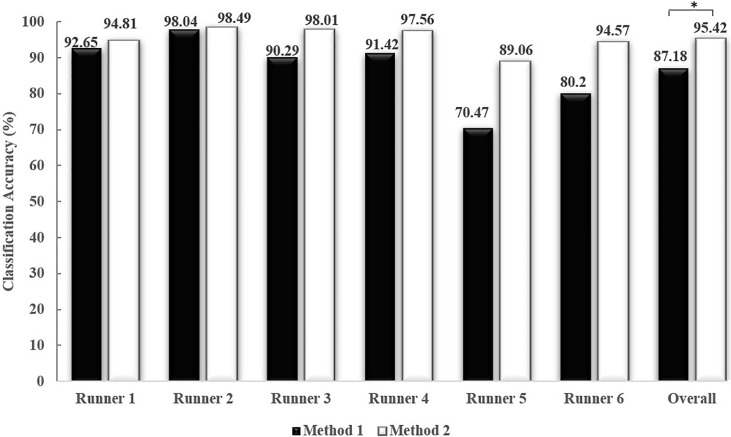
Classification accuracies obtained with Method 1 (black) and Method 2 (white); *: P<0.05.